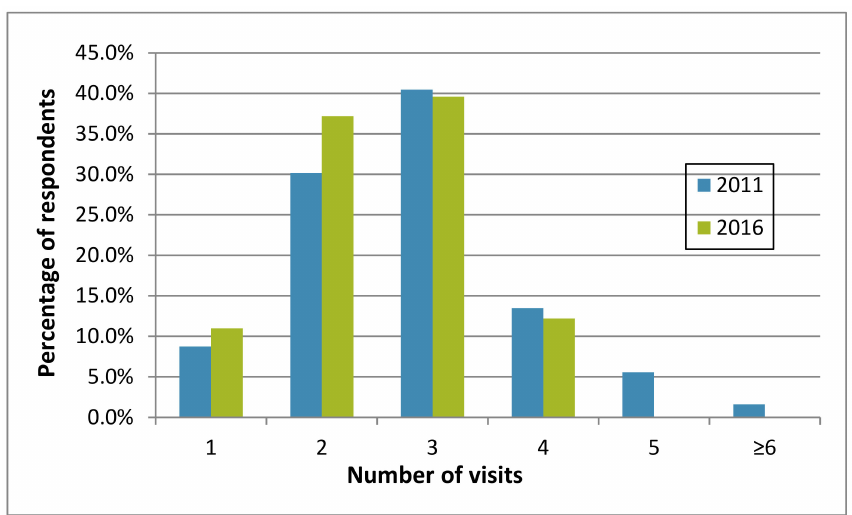
Figure 7. Number of treatment visits (1– ≥ 6) to eliminate a bed bug infestation according to survey respondents in 2011 and